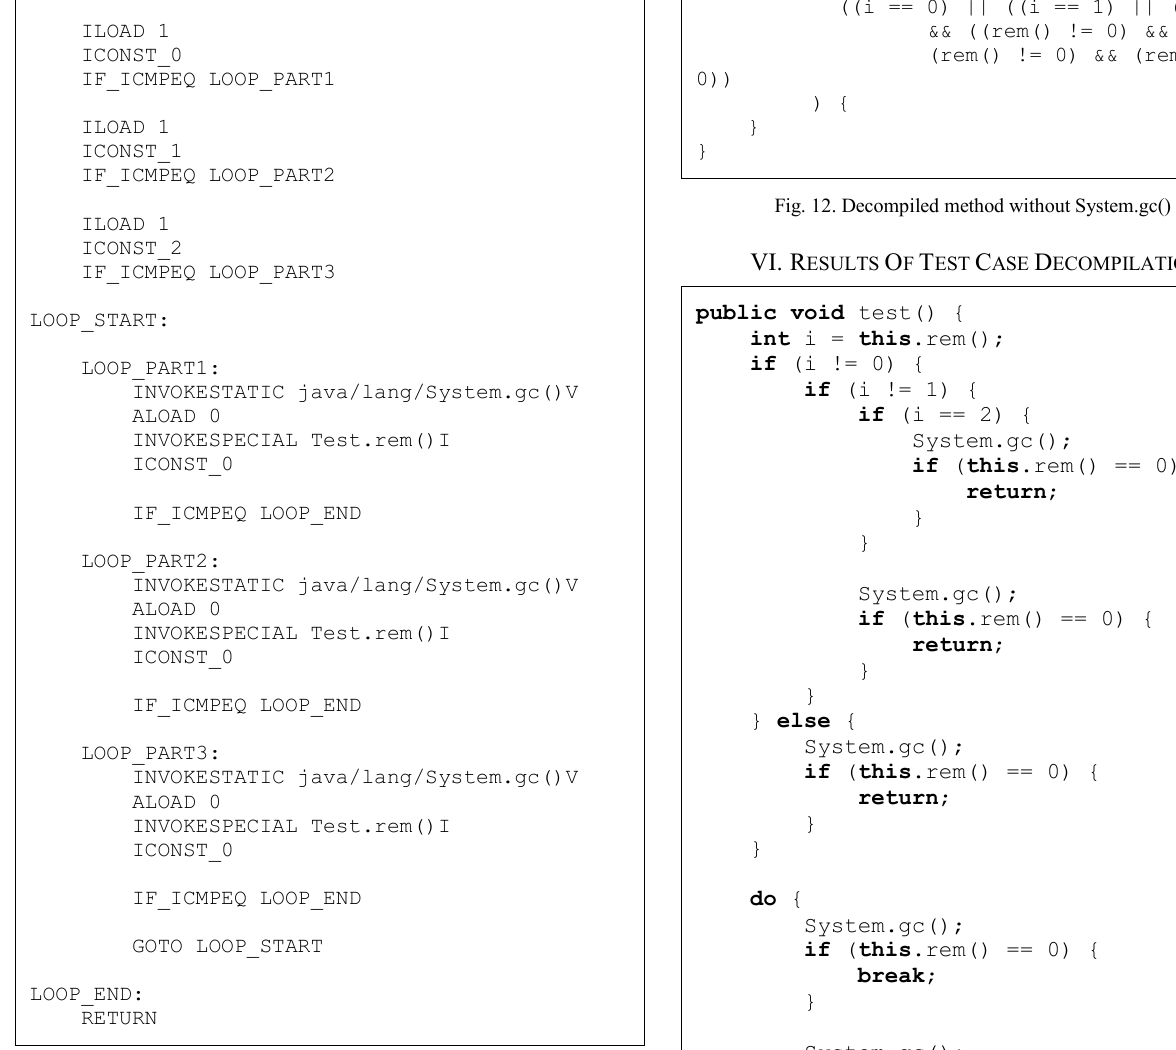
Fig. 11. The main test method.